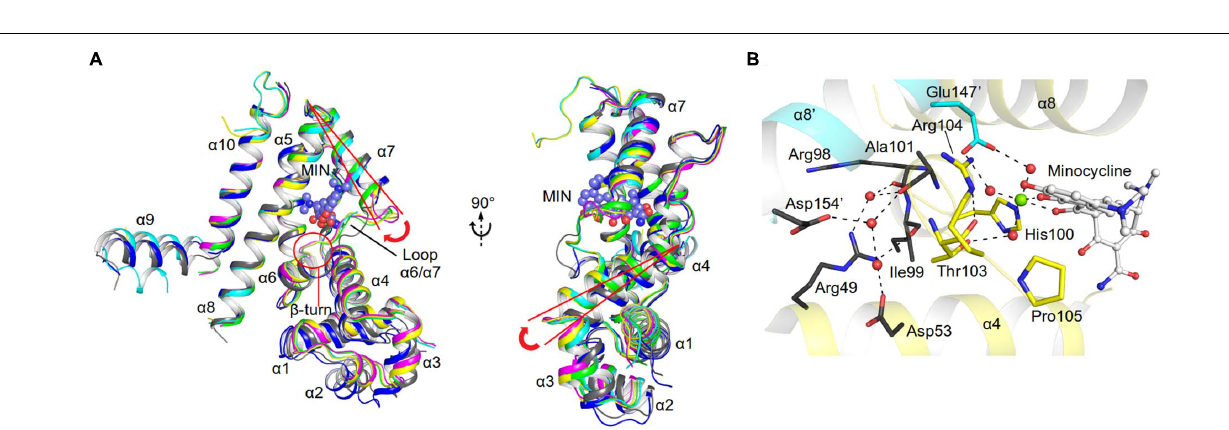
Frontiers in Microbiology |